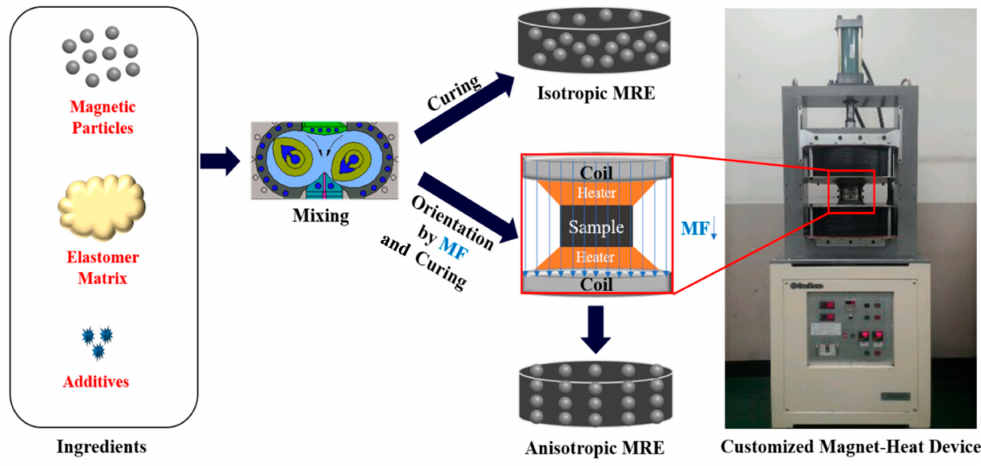
Figure 8. Diagram showing the production process of isotropic and anisotropic MREs (source: